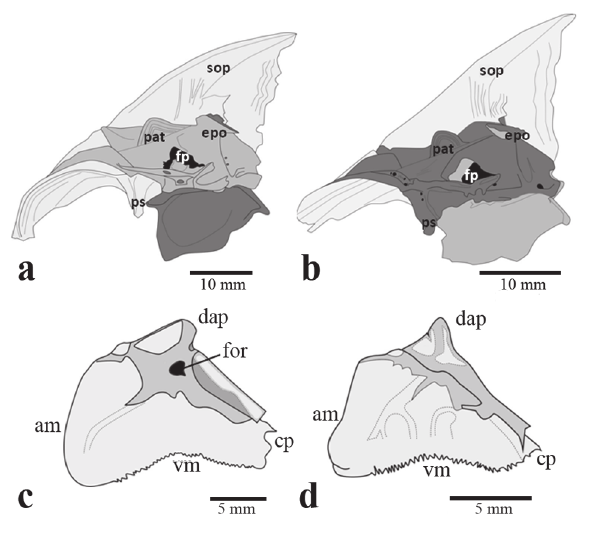
Fig. 5. Lateral view of neurocranium of ( a ) E. castroaguirrei , ECOSC 5511-1, and ( b ) E. mexicanus UABC 2666. epo = epioccipital, fp = foramen postemporal, pat = parietal, ps = pterosphenoid, sop = supraoccipital process. Lateral view of infraorbital 1 in ( c ) E. castroaguirrei and ( d ) E. mexicanus . dap = dorsal apophysis, am = anterior margin, cp = caudal process, for = foramen, vm = ventral margin. Both structures from left